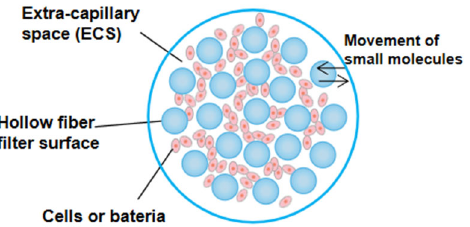
Figure 1. Cross section of hollow fiber cartridge, reprinted with permission from Ref. [4]. Copyright 2017, John Wiley and